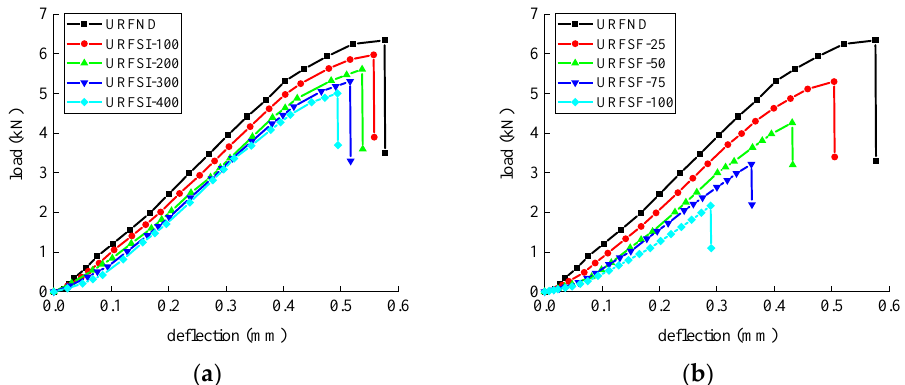
Figure 28. Flexural strength of reinforced concrete specimen: ( a ) chlorine salt immersion environment; and ( b ) salt-freeze coupled environment.